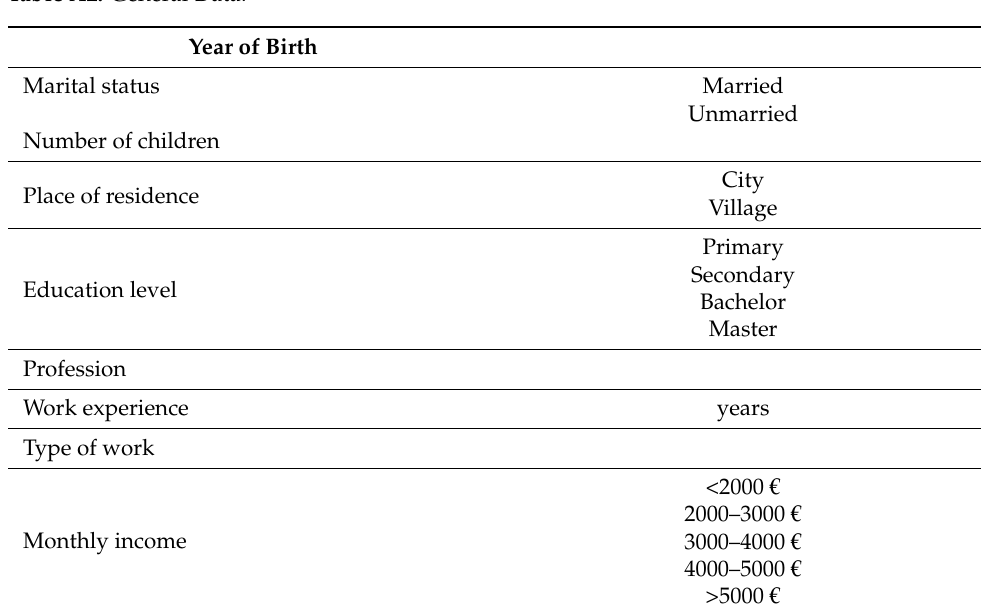
Table A2. General